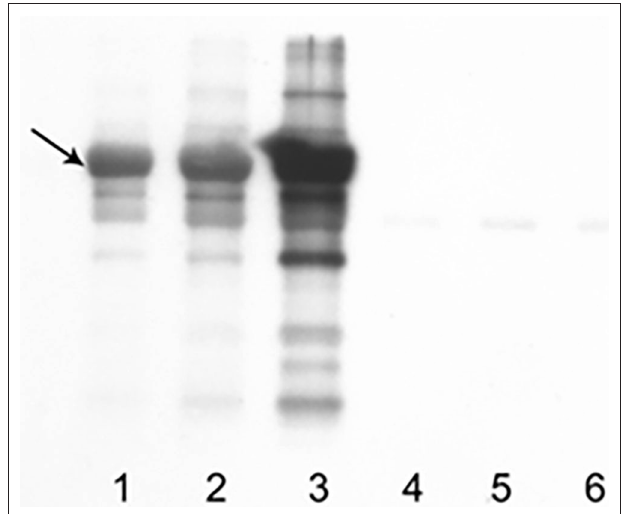
FIGURE 1 | Results obtained with WB on control samples and samples oxidized with CSE. A band of apparent MW of 69 kDa (black arrow), consistent with carbonylated dog serum albumin, is overt. In lanes 1–3, 10 µ g of sample added with DNPH were loaded (1: control, 2: solution with oxidized serum at 5%, 3: solution with oxidized serum at 10%); in lanes 4–6, same quantity and dilution of sera but without